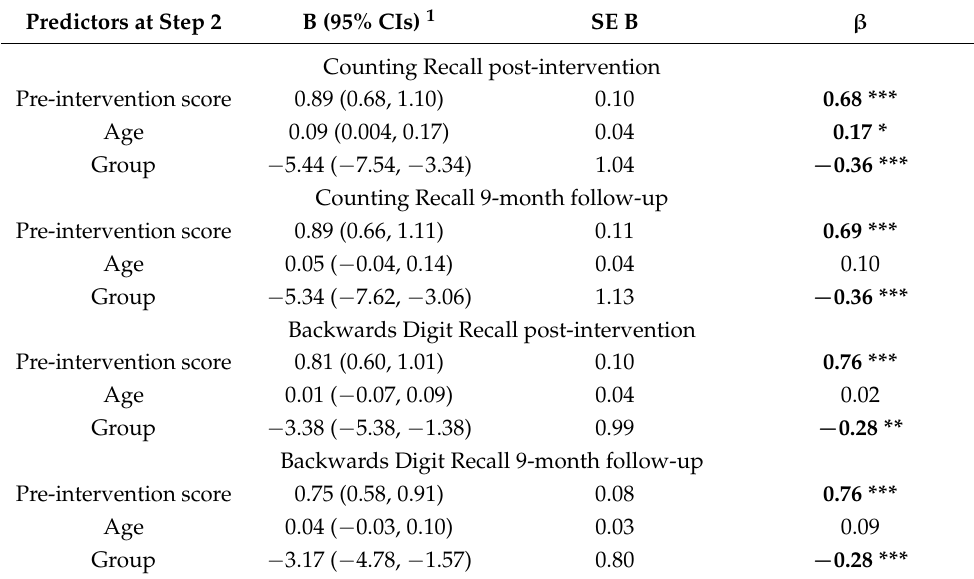
Table 6. Summary of step 2 of the regressions for the executive working-memory near-transfer outcome variables (Counting Recall, Backwards Digit